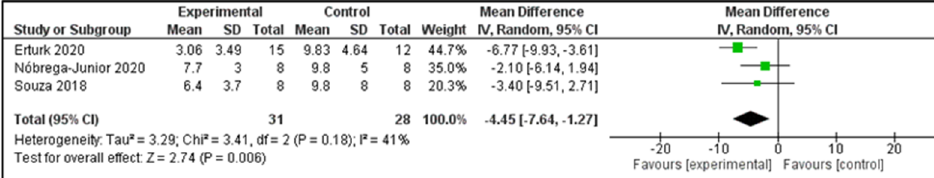
Figure 4. Forest plot for apnoea/hypopnea index.